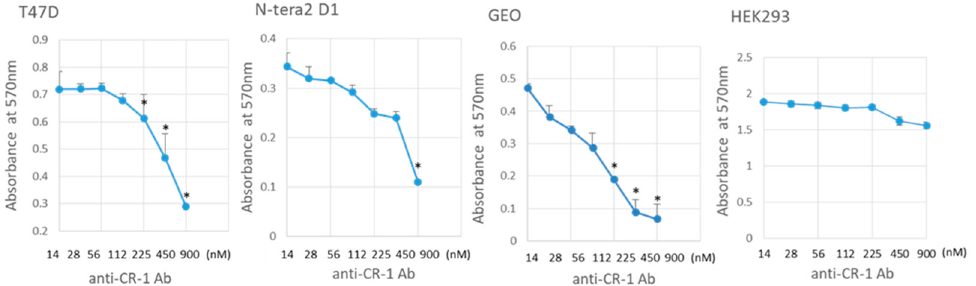
Figure 8. The cell growth inhibitory effect by anti-CR-1 antibody Clone 35. See text for details. Each plot is the mean ± SD. Significance was evaluated with the maximum point. * p < 0.05.